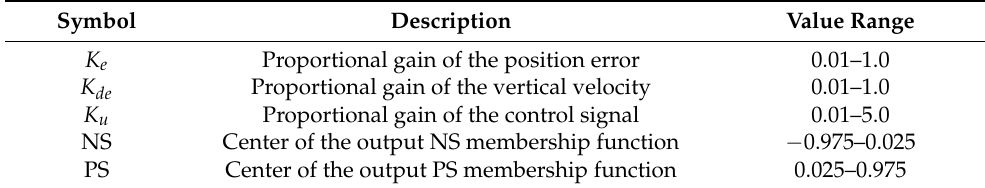
Table 2. Position FLCS parameters used in optimization design.